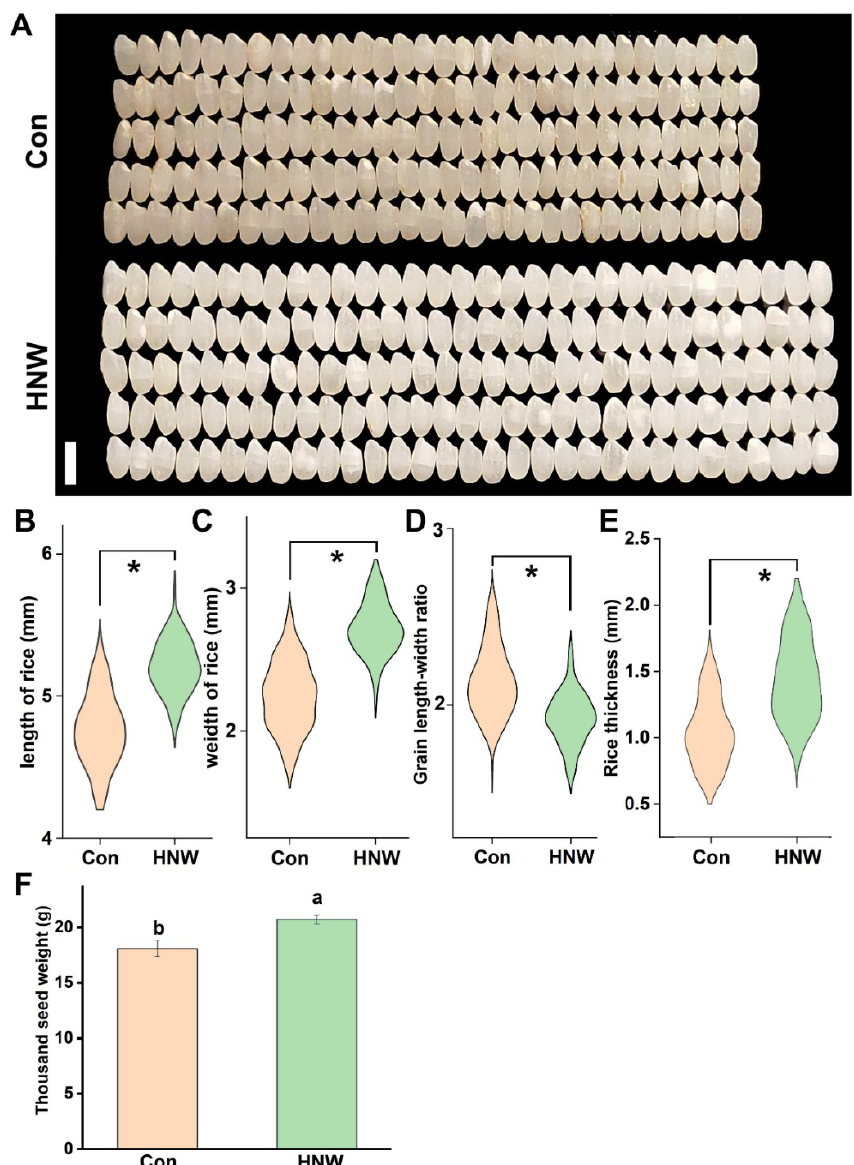
Figure 4. HNW positively influences the size and weight of white rice. The photographs of 30 white rice ( A ) were taken (bar = 0.5 cm). Parameters of white rice size, including length ( B ), width ( C ), length-width ratio ( D ), thickness ( E ), and thousand grain weight ( F ), were analyzed. Asterisk indicates a significant difference between Con and HNW (n ≥ 1000, p < 0.001, two-way Student’s t-test). Data are mean ± SD (n = 3). Bars with different letters were significantly different in comparison with Con at p < 0.05.